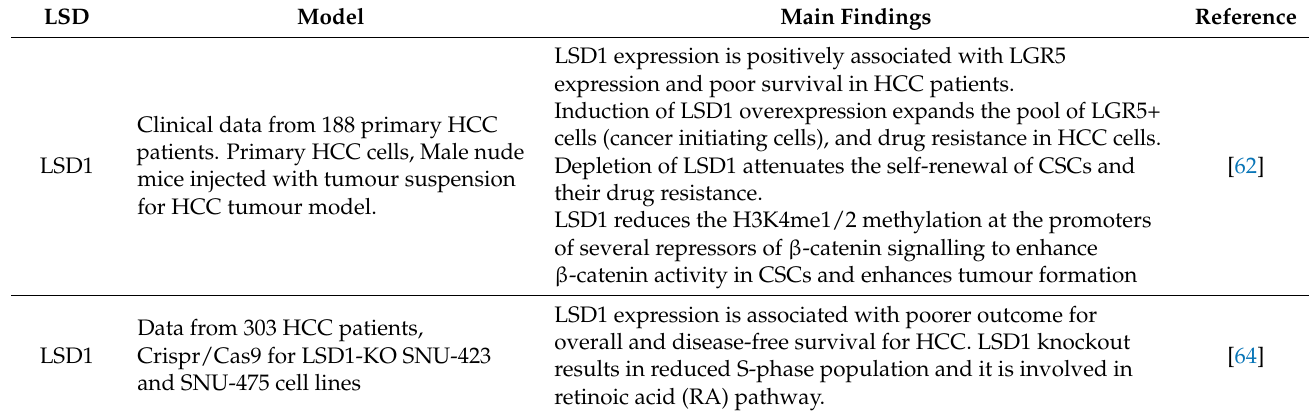
Table 2. Recent studies on LSD1/2 in liver